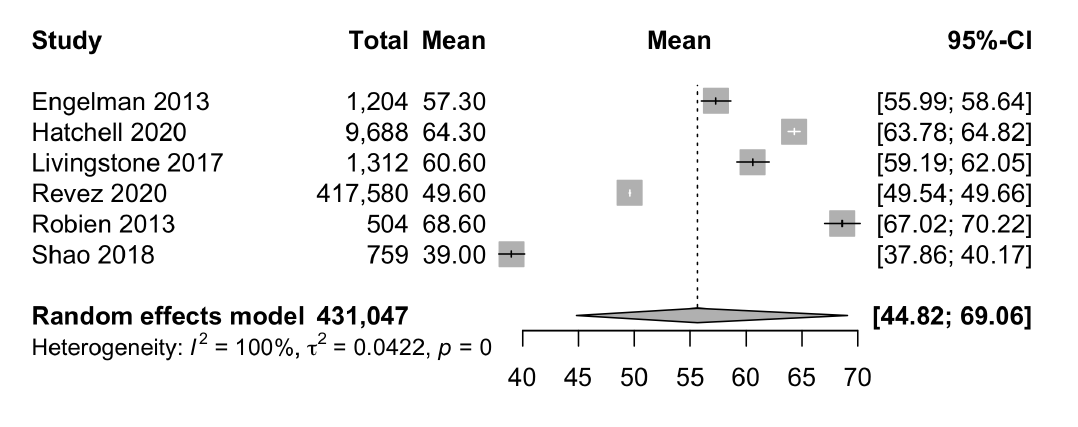
Figure 3. Pooled mean of 25(OH)D across the included studies [26–30]. Revez et al. [16] and Manousaki et al. [12] use the same population, the latter was excluded (see Methods for